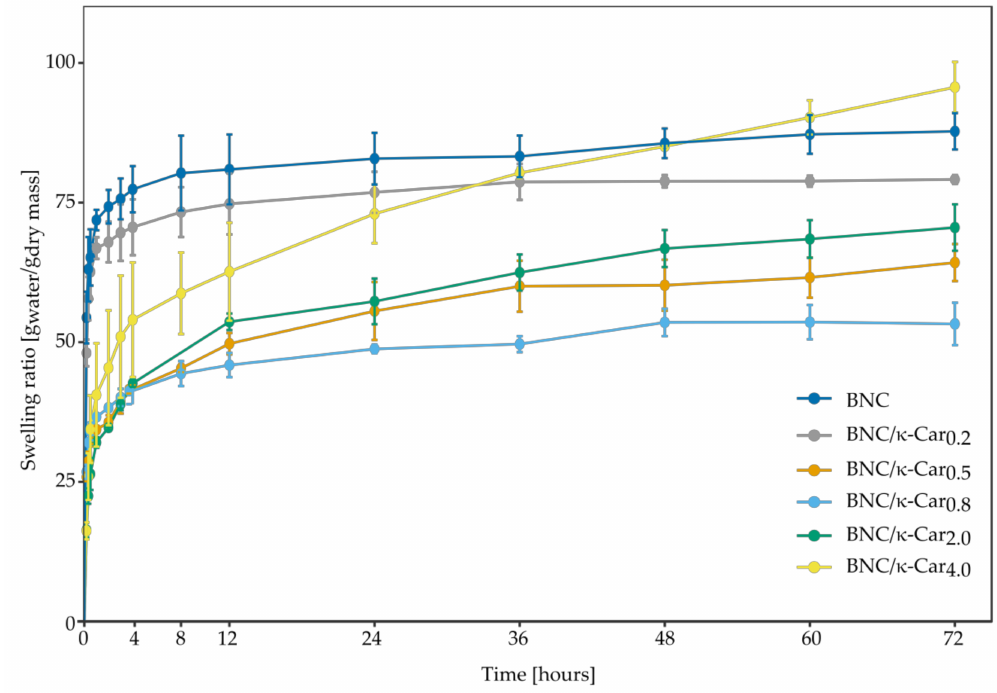
Figure 6. Swelling ratio of BNC and BNC/ κ -Car composites. (The data are presented as the means ± SD from at least three independent